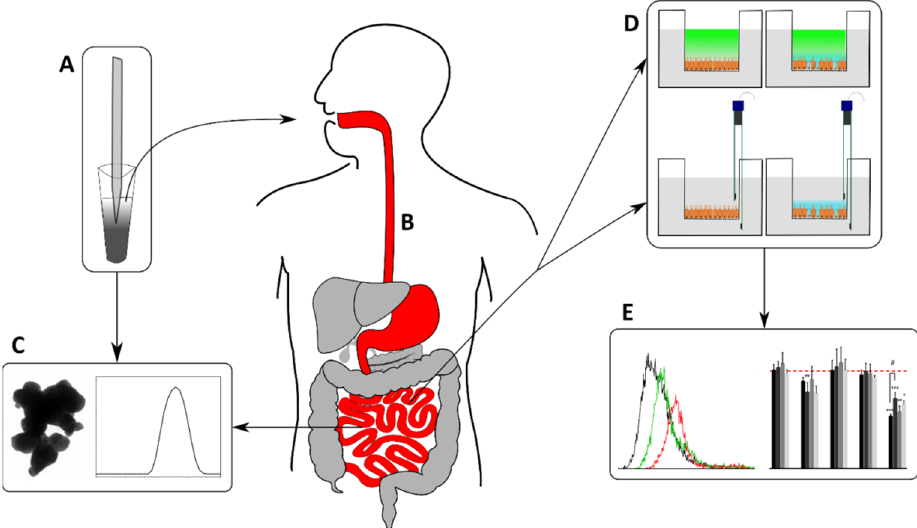
Figure 1. Schematic illustration of the applied experimental setup. ( A ) Particle dispersion preparation by ultrasonication, ( B ) artificial digestion using a static in vitro approach, ( C ) dispersion characterization by transmission electron microscopy and dynamic light scattering, ( D ) intestinal barrier integrity measurements of transepithelial electrical resistance and permeability of FITC-dextran, ( E ) analysis of cell viability and induction of apoptosis by flow cytometry. The statistical differences between the samples and the NC are marked as * p < 0.05, ** p < 0.01 and *** p < 0.001, and the statistical difference between the digested/undigested samples is marked as # p < 0.05.